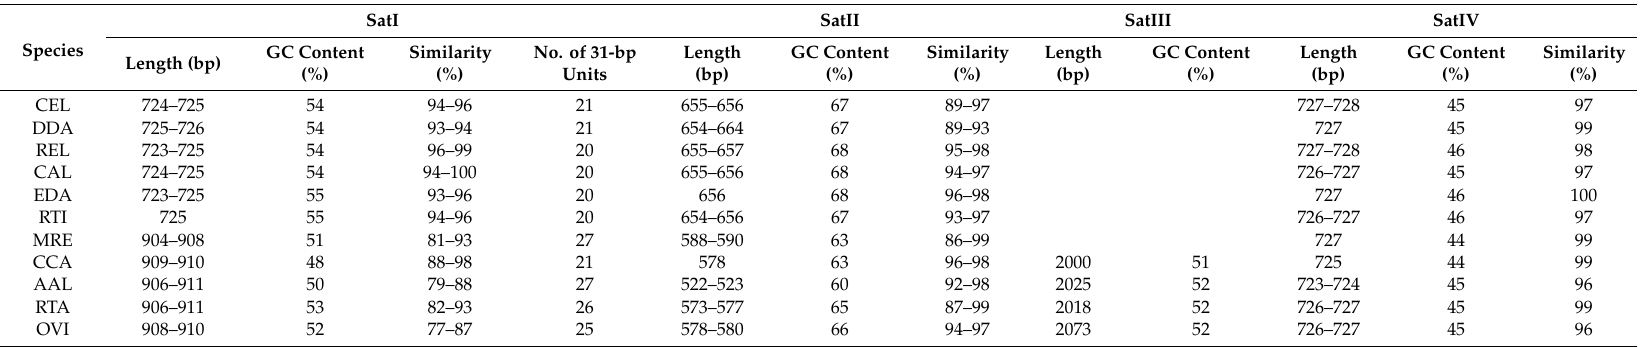
Table 2. Characteristics of the satI-IV sequences. The data are based on analyses of four clones of each satellite DNA per animal.